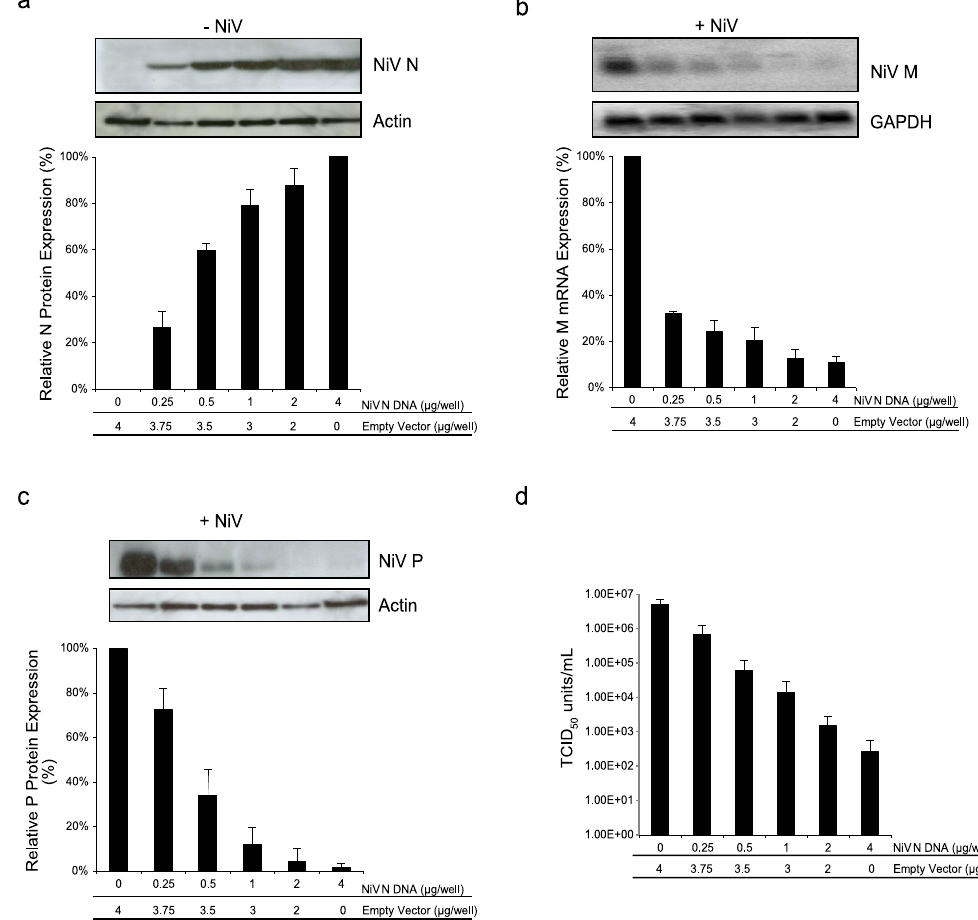
Figure 1. Effects of recombinant NiV N expression on NiV replication. Cells were transfected with increasing amounts of plasmid DNA encoding the NiV N gene. ( a ) 48 hours post transfection, cells were harvested and analyzed by western blot using a monoclonal antibody against NiV N. Western blots were quantified by densitometry and normalized to actin. Following transfection, a parallel set of cells were infected with NiV at an MOI of 1 for 24 hours. ( b ) RNA was extracted from NiV infected cells and analyzed by northern blot using a probe designed against the M gene. Northern blots were quantified by densitometry and normalized to GAPDH. ( c ) Total protein was harvested from NiV infected cells and analyzed by western blot for the expression of NiV P proteins. Western blots were quantified by densitometry and normalized to actin. ( d ) Supernatants were harvested, viral loads were determined by endpoint titration and TCID 50 /ml was calculated. All experiments were carried out in triplicate. Standard deviations of the mean were calculated. Blots have been cropped to ease